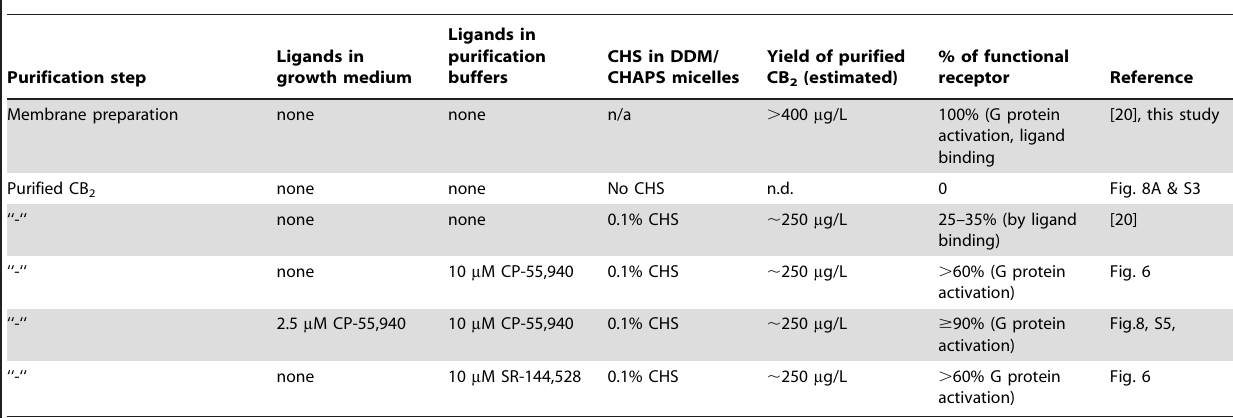
Table 1. Stabilization of CB 2 (summary). Expression and purification of functional CB 2 .